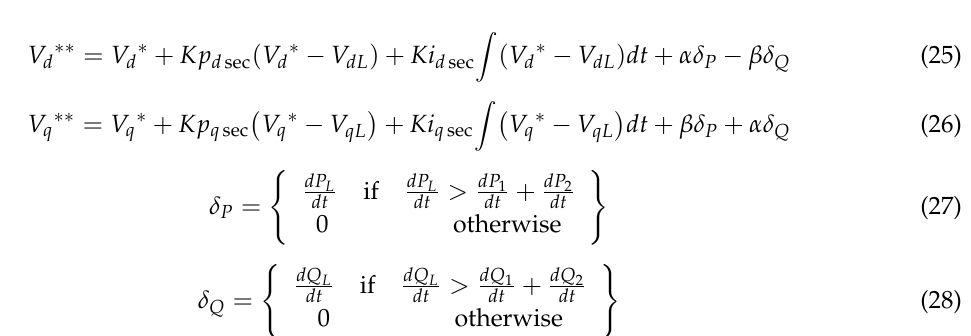
Figure 6. Proposed secondary